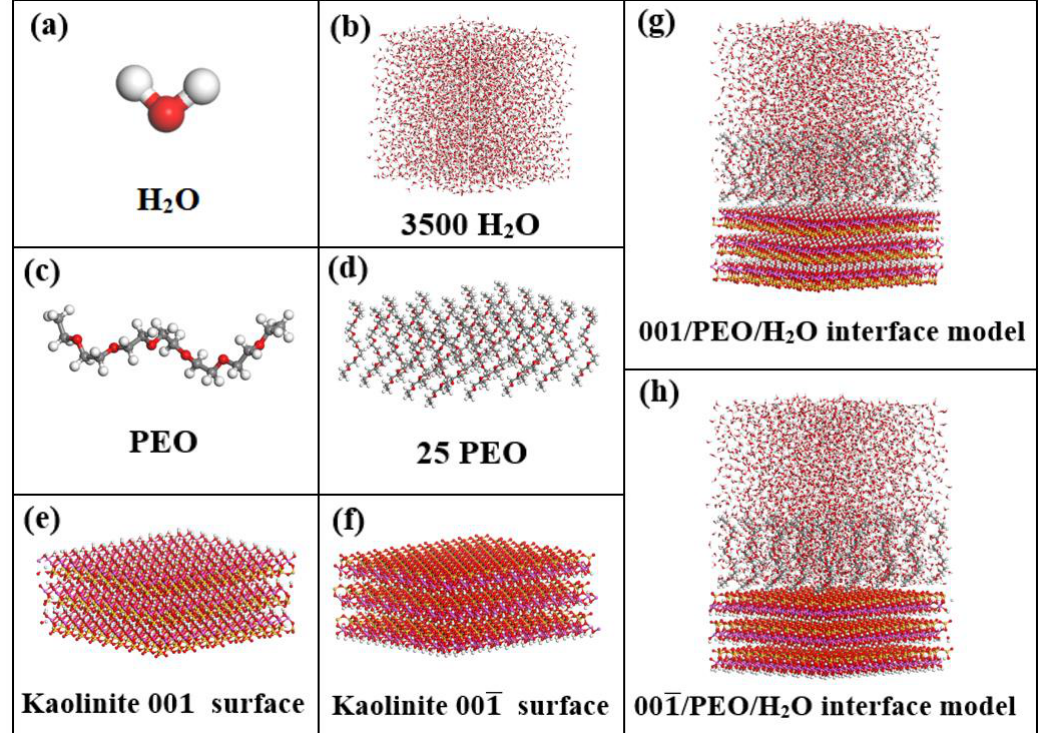
Figure 3. Molecular structures of different models: ( a ) Water molecule, ( b ) 3500 water molecules, ( c ) PEO molecular, ( d ) 25 PEO molecules, ( e ) Kaolinite 001 surfaces, ( f ) kaolinite 00 1̅ surfaces, ( g ) Kaolinite 001/PEO/H 2 O interface model, ( h ) Kaolinite 00 1̅ /PEO/H 2 O interface model. The color representation is as follows: Red — oxygen atoms, white — hydrogen atoms, yellow — silicon atoms, purple — aluminum atoms, and grey — carbon atoms. (For interpretation of the references to color in this figure legend, the reader is referred to the web version of this article.)